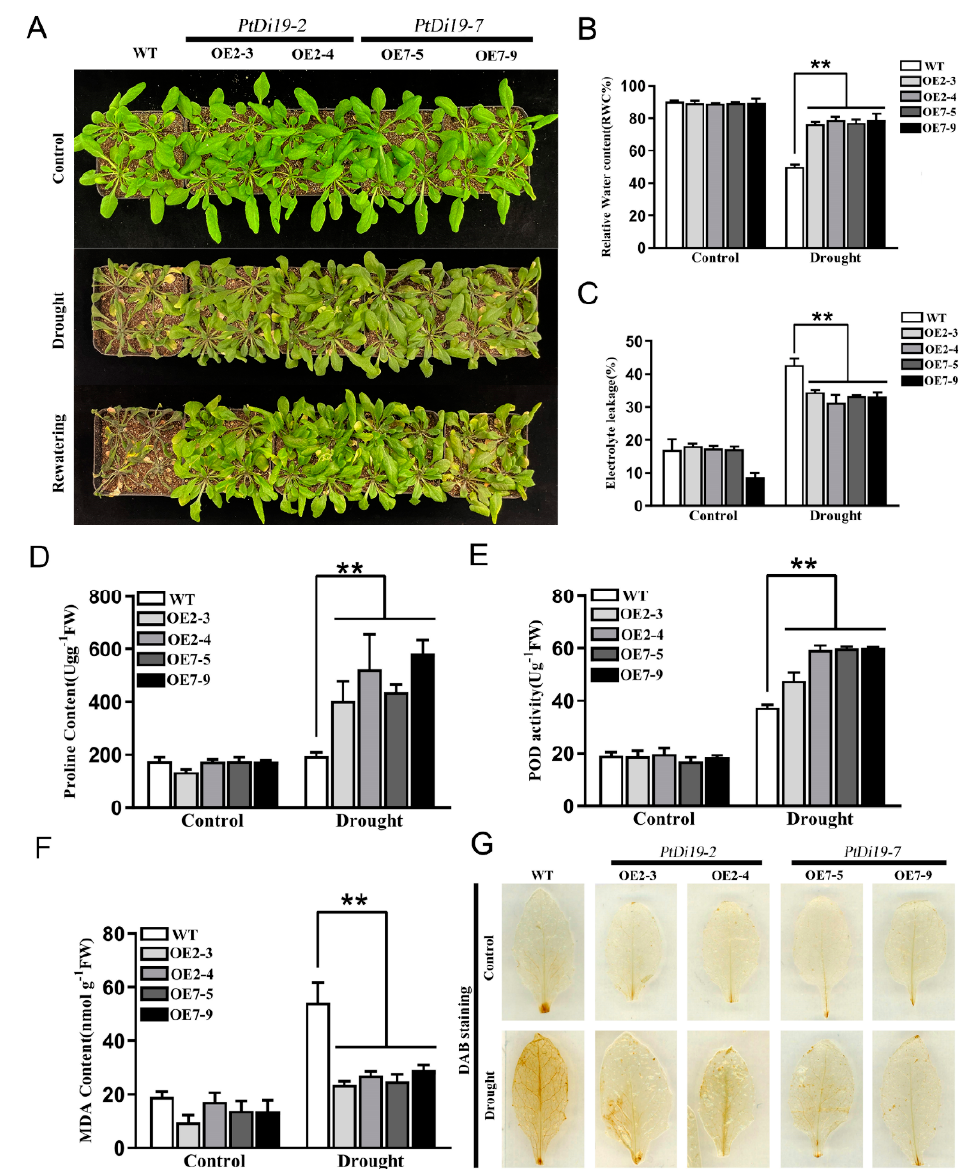
Figure 8. The PtDi19–2 and PtDi19–7 improved drought resistance in Arabidopsis . ( A ) Three week WT and transgenic plants were withheld water for 10 days to induce dehydration. After dehydration for 10 days, the representative images taken. ( B ) Relative water content of the leaves. ( C ) Electrolyte leakage. ( D ) Proline contents. ( E ) POD activity. ( F ) MDA content. ( G ) DAB staining. A p -value of <0.01 was considered to be extremely significant